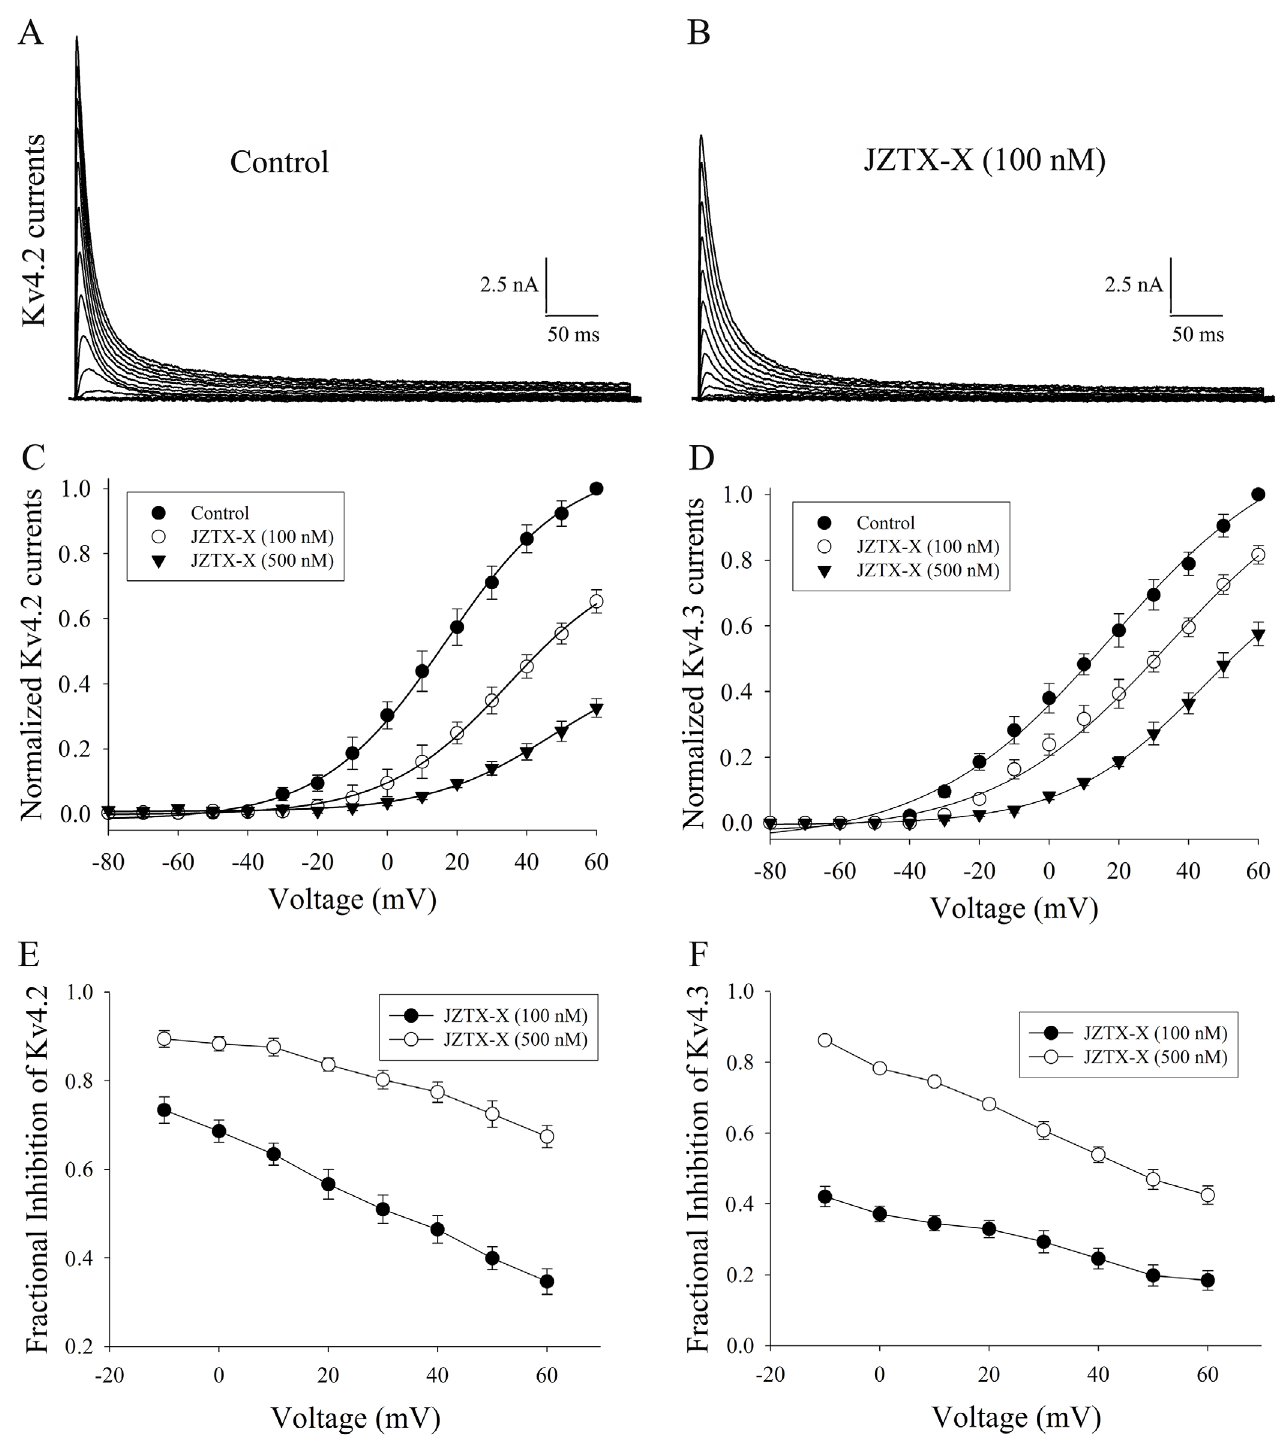
Figure 5. Effects of JZTX-X on I-V relationships in Kv4.2 and Kv4.3 channels: Each cell was held at the voltage of –80 mV, and the sodium current families were induced at the depolarization steps of 300 ms to different potentials (range, -80 mV to +60 mV at 10 mV increments). (A) and (B) showed the representative recording traces of I-V relation for the Kv4.2 currents before and after 100 nM JZTX-X treatment, respectively. (C) and (D) represented I-V relation for Kv4.2 (C) and Kv4.3 (D) currents before (filled circles) and after 100 nM (open circles) or 500 nM (filled inverted triangles) JZTX-X treatment, respectively. (E) and (F) represented the fractional suppression on Kv4.2 (E) and Kv4.3 (F) currents after 100 nM (filled circles) and 500 nM (open circles) JZTX-X treatment, respectively. All data were expressed as mean ± S.E.M (n = 5-7